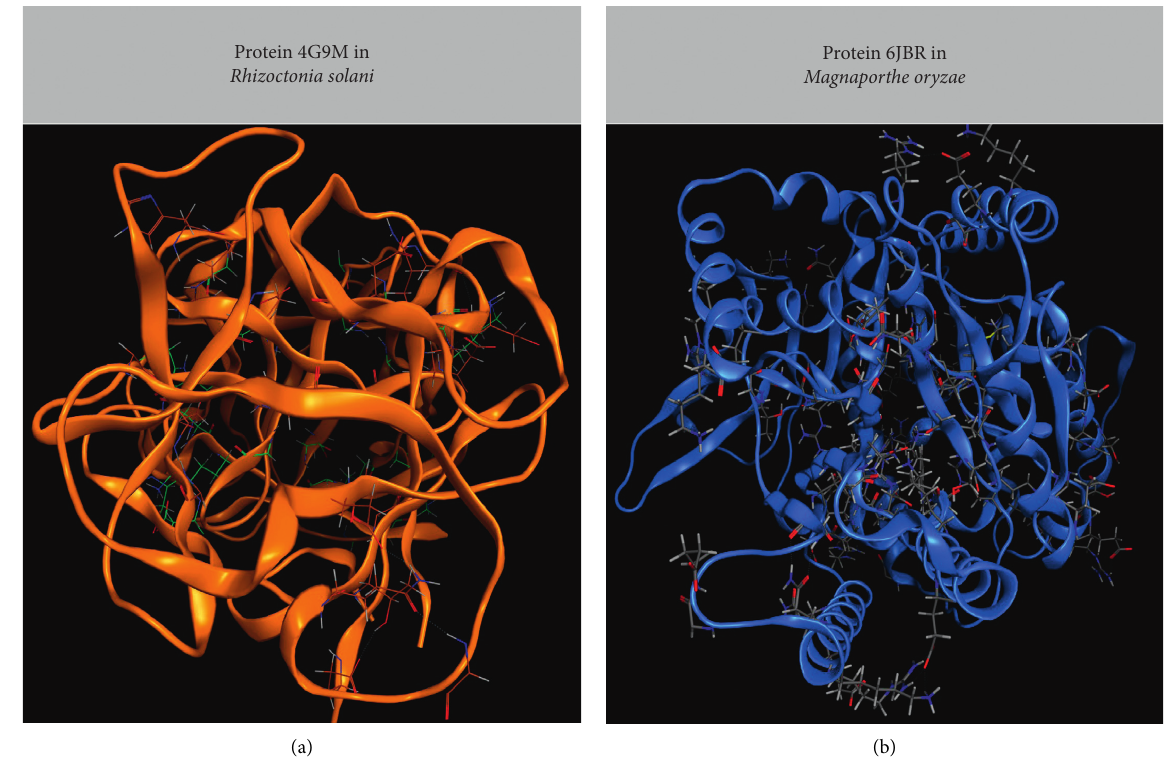
Figure 1: (a) Protein 4G9M in Rhizoctonia solani (DOI:10.2210/pdb4G9M/pdb) and (b) protein 6JBR in Magnaporthe oryzae (DOI:10.2210/ pdb6JBR/pdb), referenced from Worldwide Protein Data